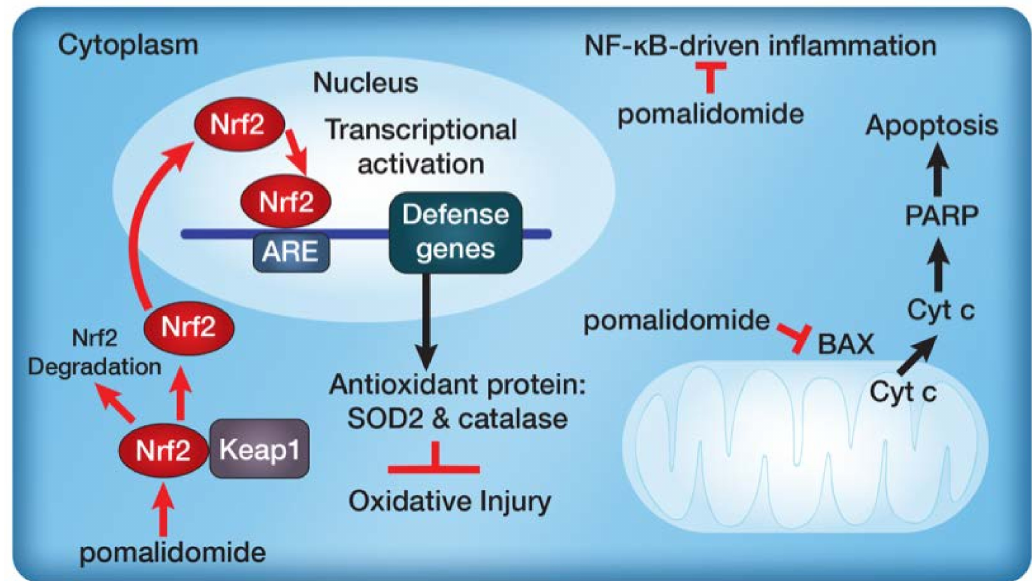
Figure 6. Proposed neuroprotective mechanisms underlying the cellular responses to H 2 O 2 -induced oxidative stress after pre-treatment with pomalidomide via Nrf2-SOD2/Catalase anti-oxidative signaling pathway and BAX-Cytochrome c (Cyt c)-PARP anti-apoptosis signaling pathway. Nrf2, nuclear factor erythroid derived 2; SOD2, superoxide dismutase